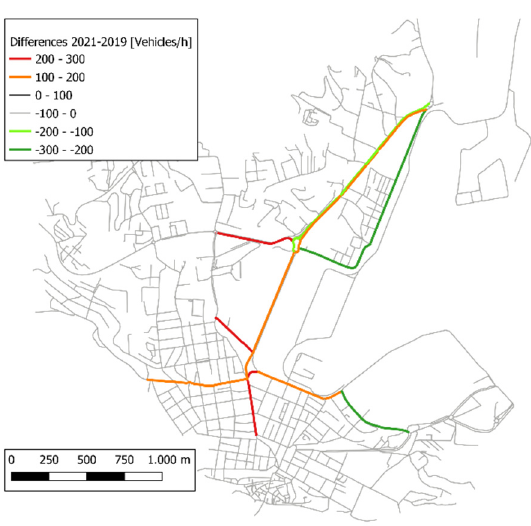
Figure 12. Road graph highlighting the differences in flows between 2021 and 2019 for vehicles category 1 in day period.